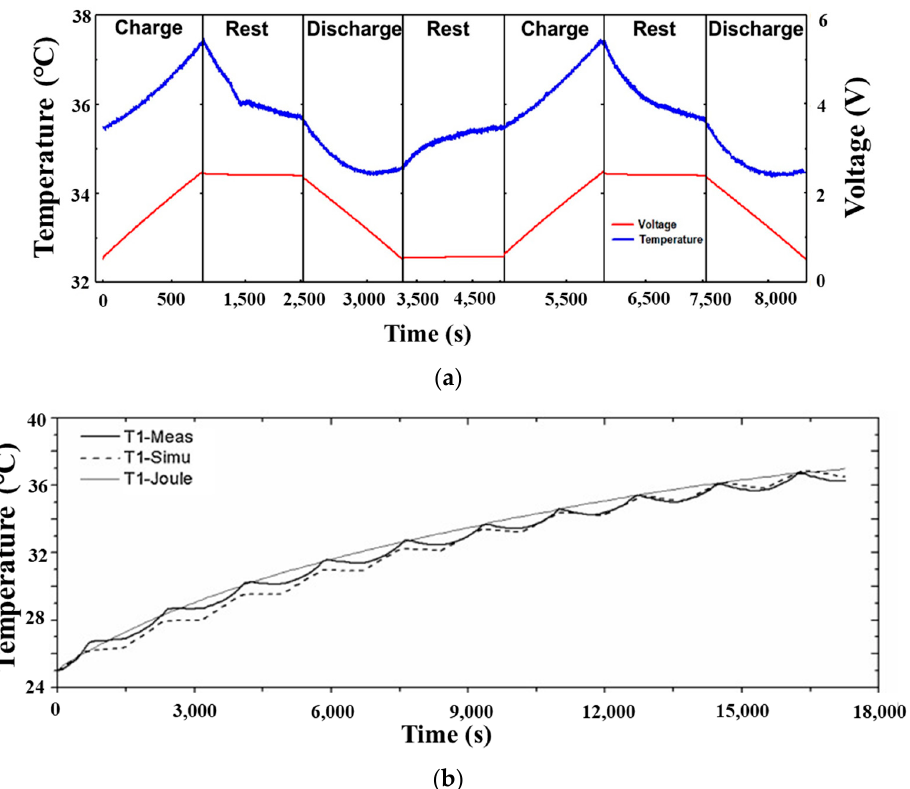
Figure 7. ( a ) Temperature versus time during the charging and discharging process for the EDLC with AC//AC; ( b ) temperature fluctuations with time for the EDLC with reversible heat during the charging and discharging cycles, reproduced with permission from [98]. Copyright 2016, Elsevier.